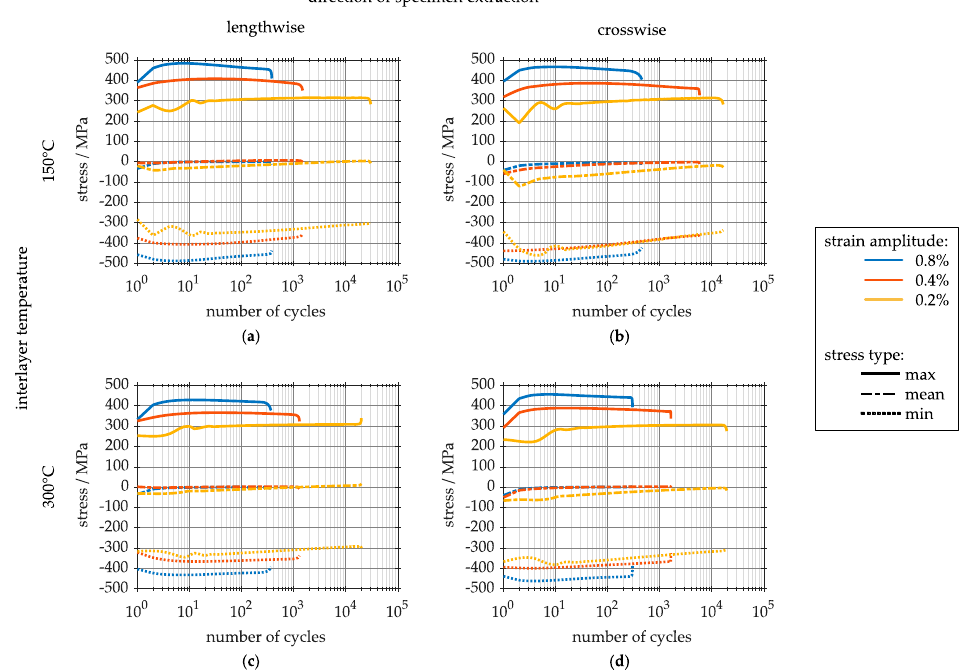
Figure 10. Cyclic hardening/softening curves for three exemplary strain amplitudes (semi-logarithmic scale) for interlayer temperature of 150 °C for lengthwise ( a ) and crosswise ( b ) extraction direction and for interlayer temperature of 300 °C for lengthwise ( c ) and crosswise ( d ) extraction direction.